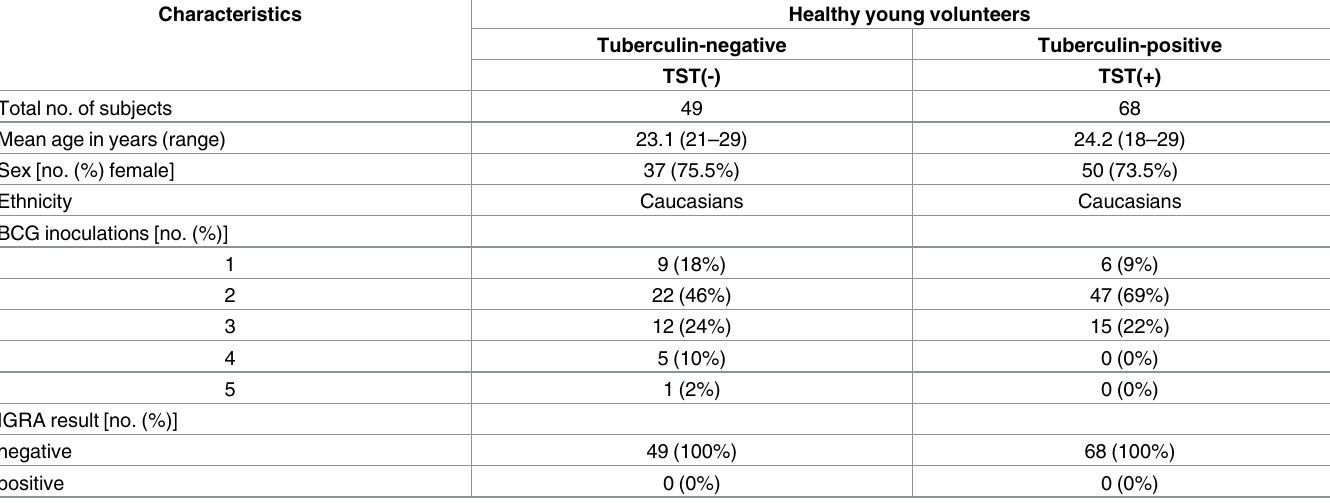
Table 1. Characteristics of the healthy young volunteer group under study.